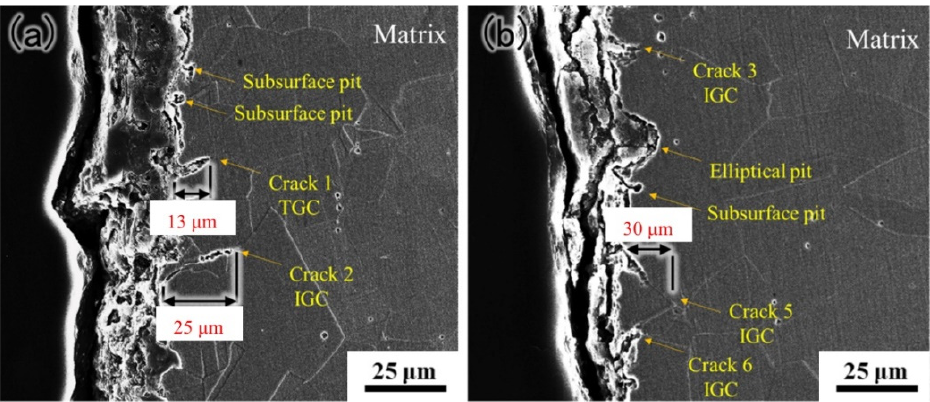
Figure 12. The cross-section morphologies of external tube at two different locations ( a ) and ( b ).